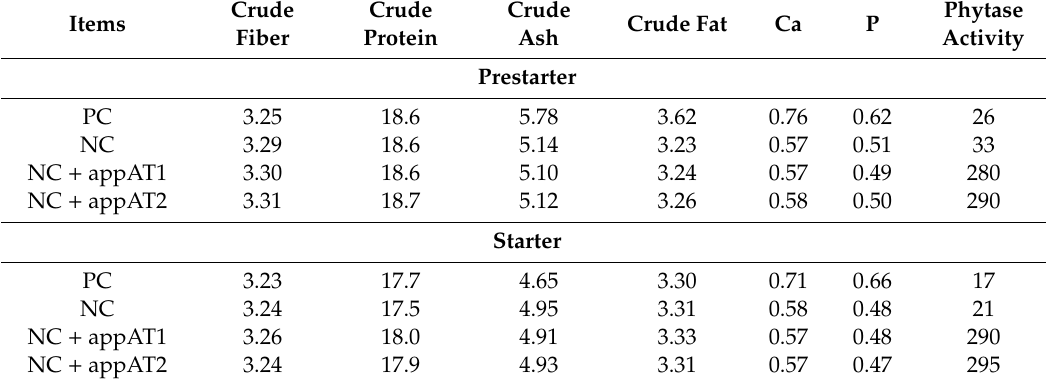
Table 2. Chemical analysis (in %) and phytase activity (in FTU / kg) of the positive control (PC), negative control (NC), or NC supplemented with phytase (appAT1 or appAT2) for the prestarter and starter